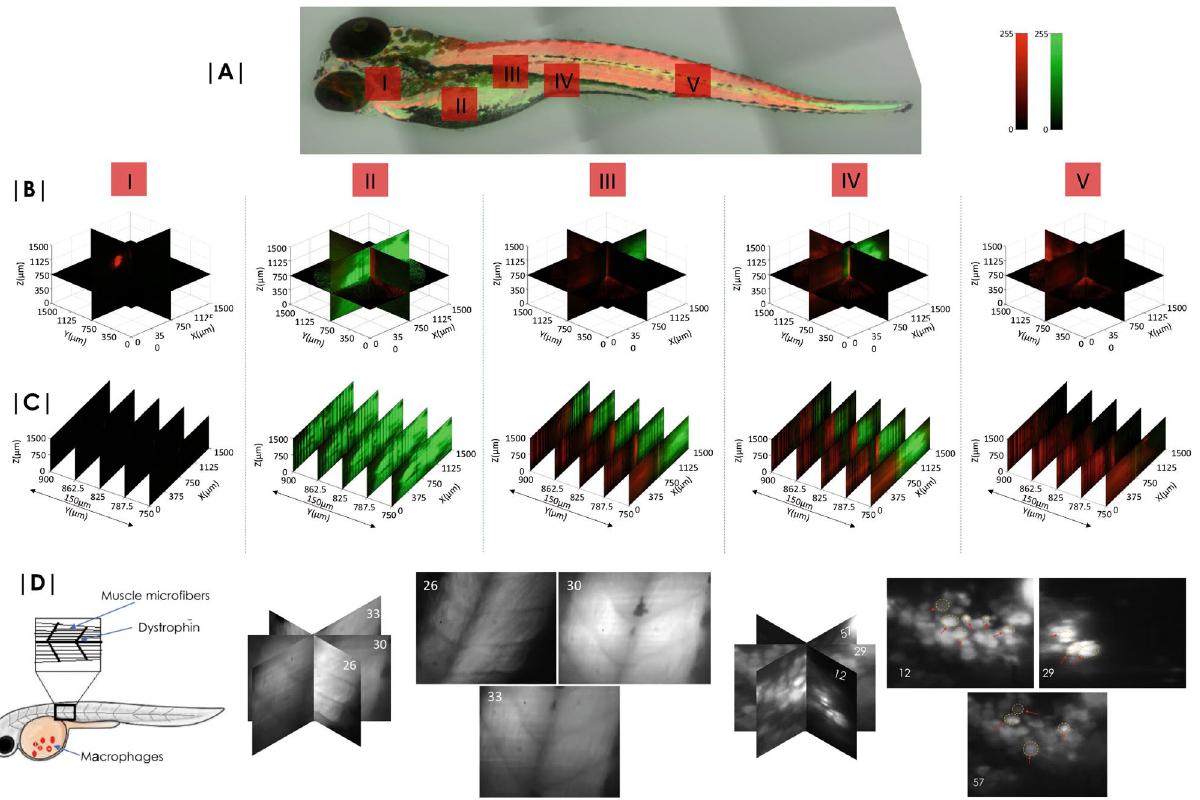
Figure 5. Zebrafish embryo imaging. ( A ) Leica confocal images (tiled) of entire Zebrafish with a 10X objective lens. 48 h Zebrafish embryo with muscles and yolk stained with TRITC and BODIPY respectively show the distribution of lipids and muscles. ( B ) Reconstructed volume images of specific sections (marked I-V) of embryo are also shown. ( C ) 2D slice images from the reconstructed volume. ( D ) Images of muscle structure (planes, 26, 30 and 33) and primitive macrophages (planes, 12, 29 and 57) 24 hours post fertilization. (See, Supplementary 7 for